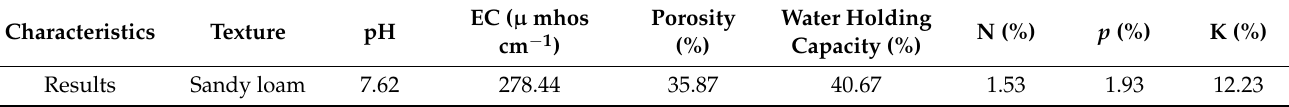
Table 1. Physicochemical characteristics of the